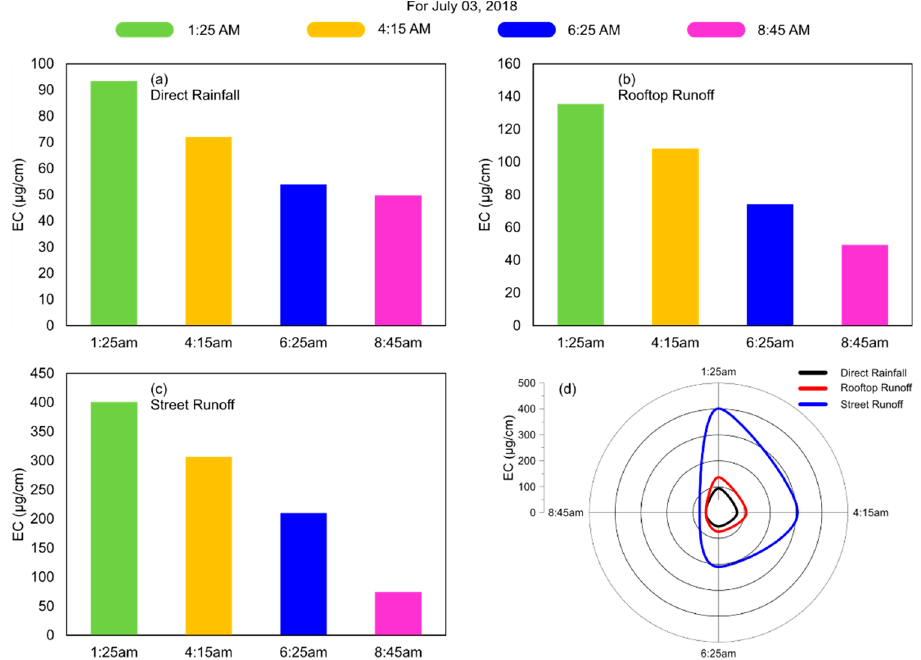
Figure 8. Intraday profile of electrical conductivity (µg/cm) (on 3 July 2018) at Site S3—Field Research Station Babakwal, Tehsil Ferozewala, District Sheikhupura, where ( a ) represents direct rainfall, ( b ) represents rooftop runoff, ( c ) represents street runoff, and ( d ) illustrates comparative analysis of the three selected categories on polar chart for different rainfall events.